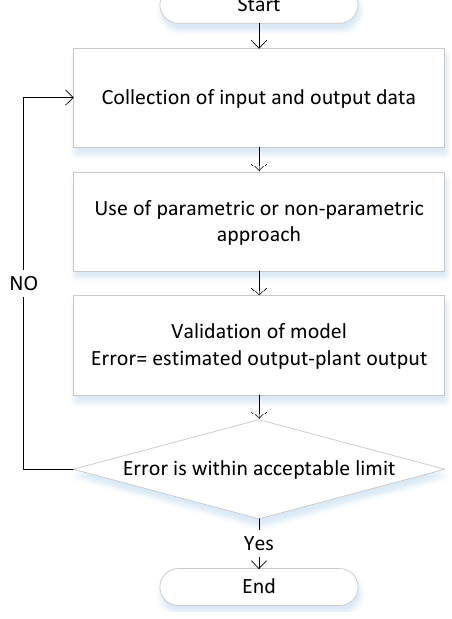
Figure 6. Model-free approach process.